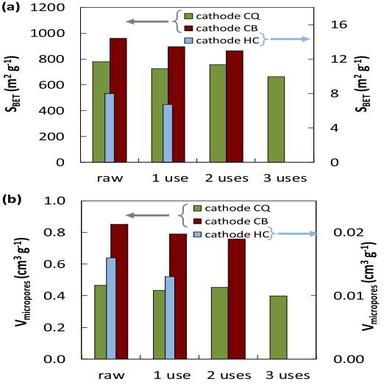
Characterization of the porosity of the cathodes loaded with iron using the "pre" methodology before and after various uses: (a) specific surface area, (b) volume of micropores. Data of cathode HC is plotted in the second axis for clarity.